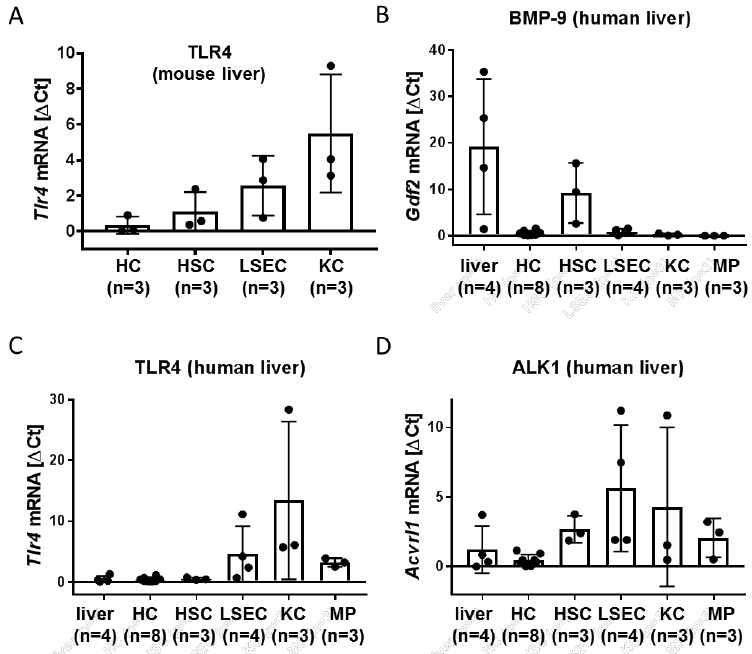
Figure 1. Expression of BMP-9 and LPS receptors in different liver cell types. ( A ) Four different liver cells types (hepatocytes (HCs), HSCs, liver sinusoidal endothelial cells (LSECs) and Kupffer cells (KCs)) were simultaneously isolated from healthy mouse livers, directly lysed and total RNA was purified. Tlr4 expression levels were determined by RT-qPCR. Data were normalized to the average Ct value of each individual experiment (isolation): Ct-target gene minus Ct-average. Results are presented ± SD from n = 3 isolations. ( B – D ) HSC, KC, HC or LSEC were isolated from human resected (non-malignant) liver tissue from the surrounding of colorectal cancer metastases. KC, HC and LSEC were directly lysed for RNA purification, HSC were cultured for a few days. Macrophages (MP) were generated from monocytes isolated from the blood of healthy donors by 1-week culture in serum-containing medium. For comparison RNA samples of whole liver tissue were additionally analyzed (“liver”). Expression levels of Bmp-9 (B),Tlr4 ( C ) and Alk1 ( D )were determined by RT-qPCR and normalized as in ( A ). Data are expressed as average values ± SD (ΔCt of target gene versus the average Ct of all samples). Each dot represents an individual cell isolation. 3.2. Factors Secreted from LSEC, Including IL-6, Induce BMP-9 Expression in MF Since BMP-9 itself is produced mainly in hepatic stellate cells (HSC) [5] (Figure 1B) and cross-talk between LSEC and HSC has been described [18], we next addressed the question of whether responses of LSEC to LPS might directly affect the neighbouring HSC or other fibroblastic liver cells. For this purpose, we used human upcyte ® LSEC and collected the conditioned medium from control- versus LPS-treated cells. We exposed primary human liver myofibroblasts (MF) that had been initially isolated from liver resection samples of patients to this medium and analyzed RNA expression changes. While classical fibrogenic markers like alpha-smooth-muscle actin (αSMA) or collagen type I (Col1a1) were not induced (Col1a1 was even significantly reduced), expression of BMP-9 itself was upregulated by the medium of LPS-treated LSEC (Figure 2A). These results imply that LPS initiates the secretion of factor(s) from LSEC that may not directly enhance fibrogenic activation of the cells but does cause increased expression of BMP-9. Since LPS led to a strong induction of IL-6 in LSEC (Figure 3A), we tested if IL-6 induces BMP-9 expression in MF. As shown in Figure 2B, this was indeed the case.